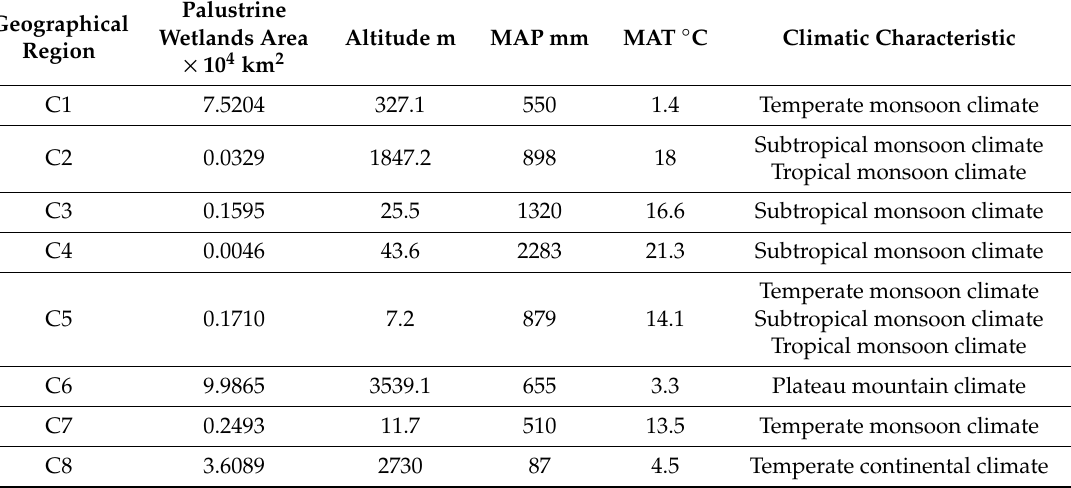
Table 1. Natural properties of geographical